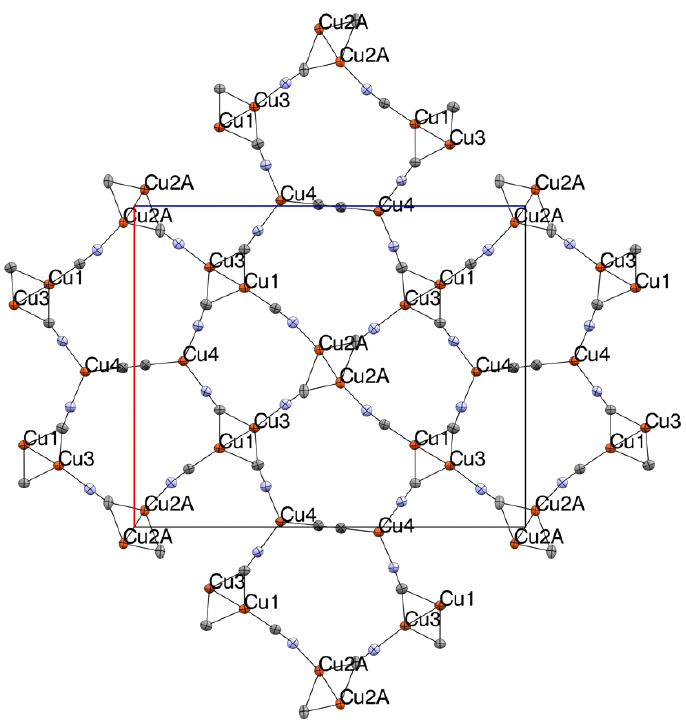
Figure 1. Thermal ellipsoid (50% probability) packing diagram of 1 , projected along the b -axis, showing network formation. Me 4 N + cations omitted for clarity. Cu orange, N blue, C grey. Selected bond lengths and angles (X = disordered C/N): Cu1-X1 1.960(4), Cu1-X3 2.236(4), Cu1-X4 2.089(4),